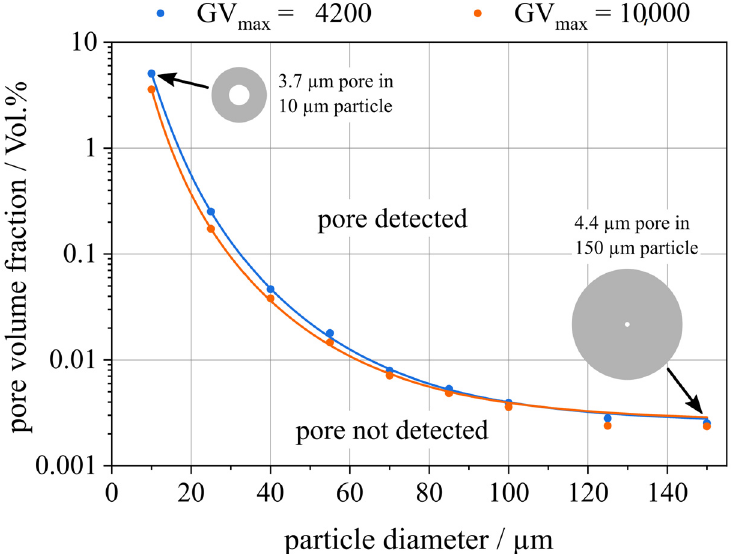
Figure 8. Minimum volume of pores detectable by digital radiography in metallic powder particles with diameters between 10 µm and 150 µm expressed as the pore volume fraction of the powder particles. The fraction of the detectable pore volume decreases rapidly with particle size. The schematic insets are not to scale.